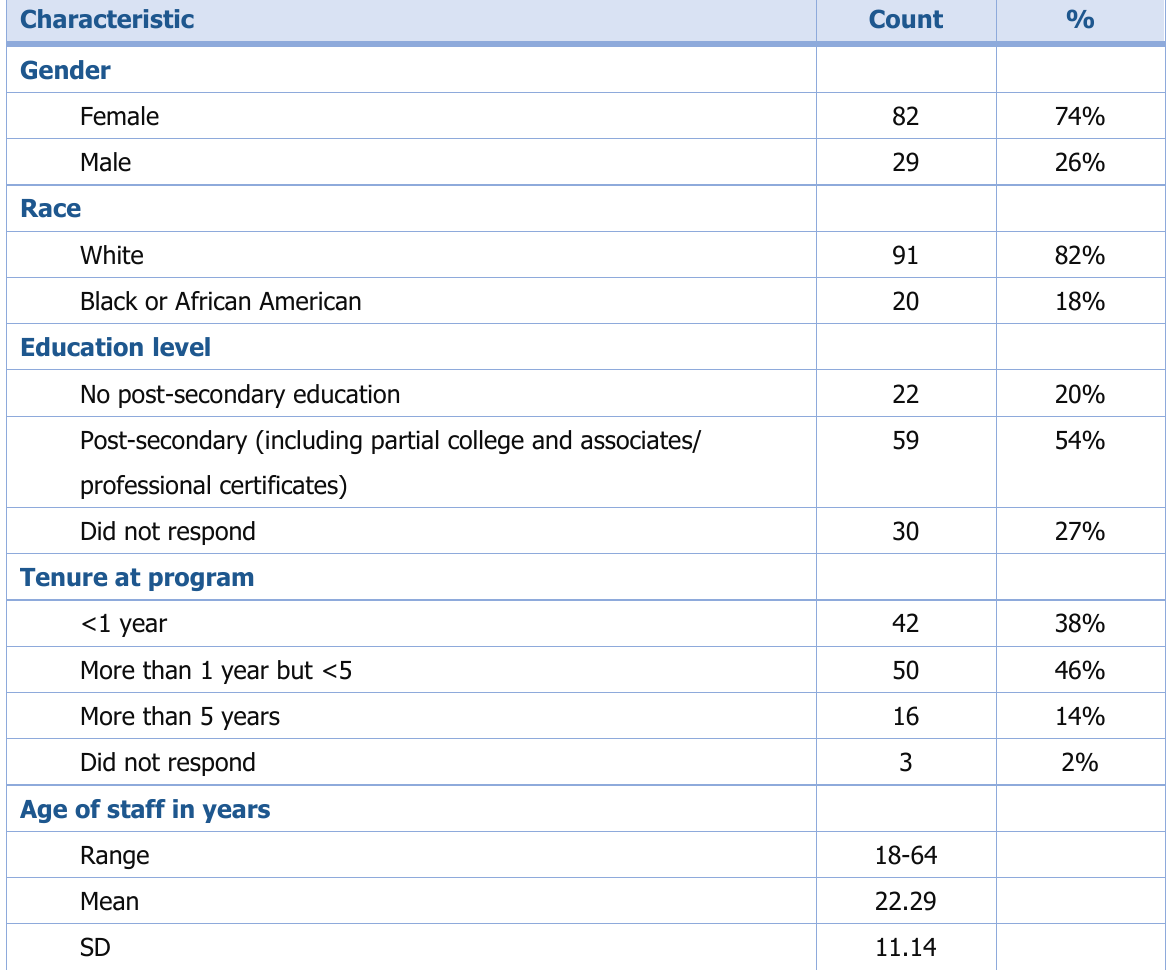
Table 1. Sample Demographics of Staff (N = 111)